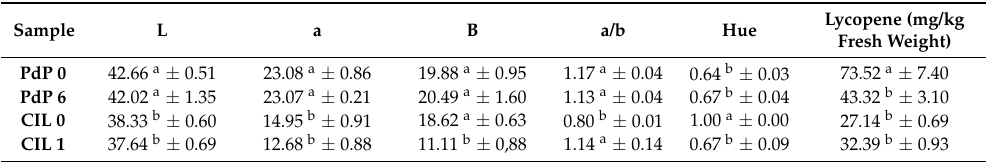
Table 2. Colour readings and lycopene content (mean ± standard deviation) in tomato samples. Sample L